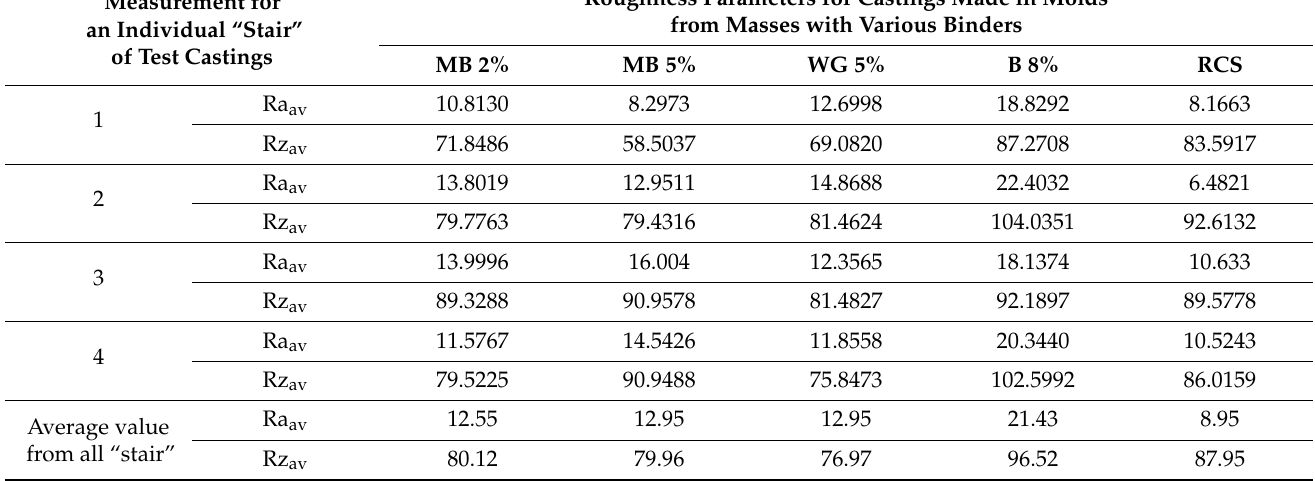
Table 4. Results of roughness measurements of castings made of molds from molding sands with the addition of various